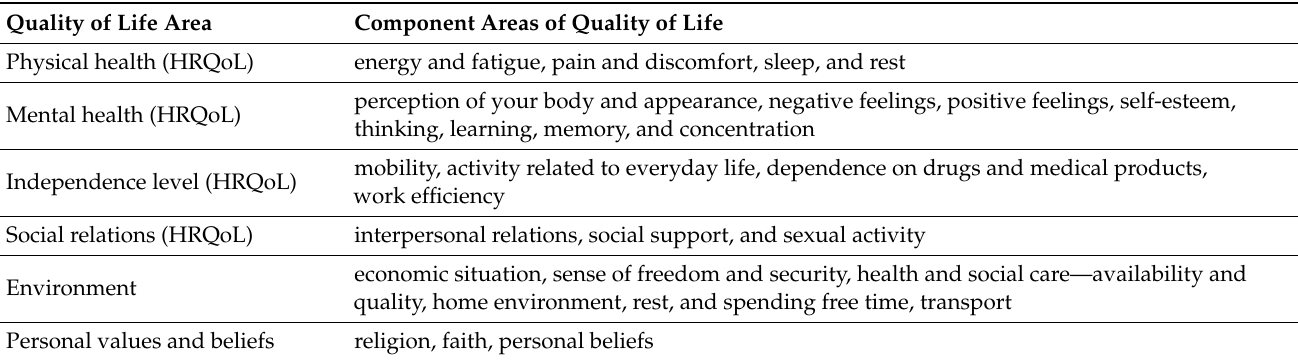
Table 1. Quality-of-life areas as defined by WHO based on